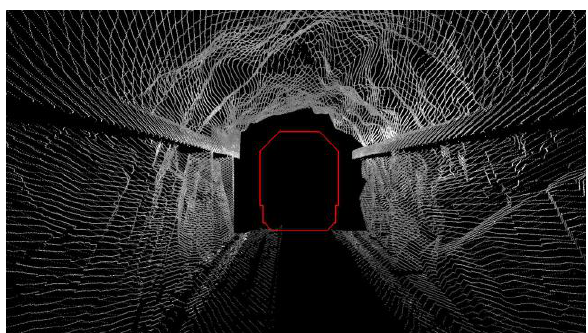
Figure 12: Checking the clearance inside a tunnel with TerraScan